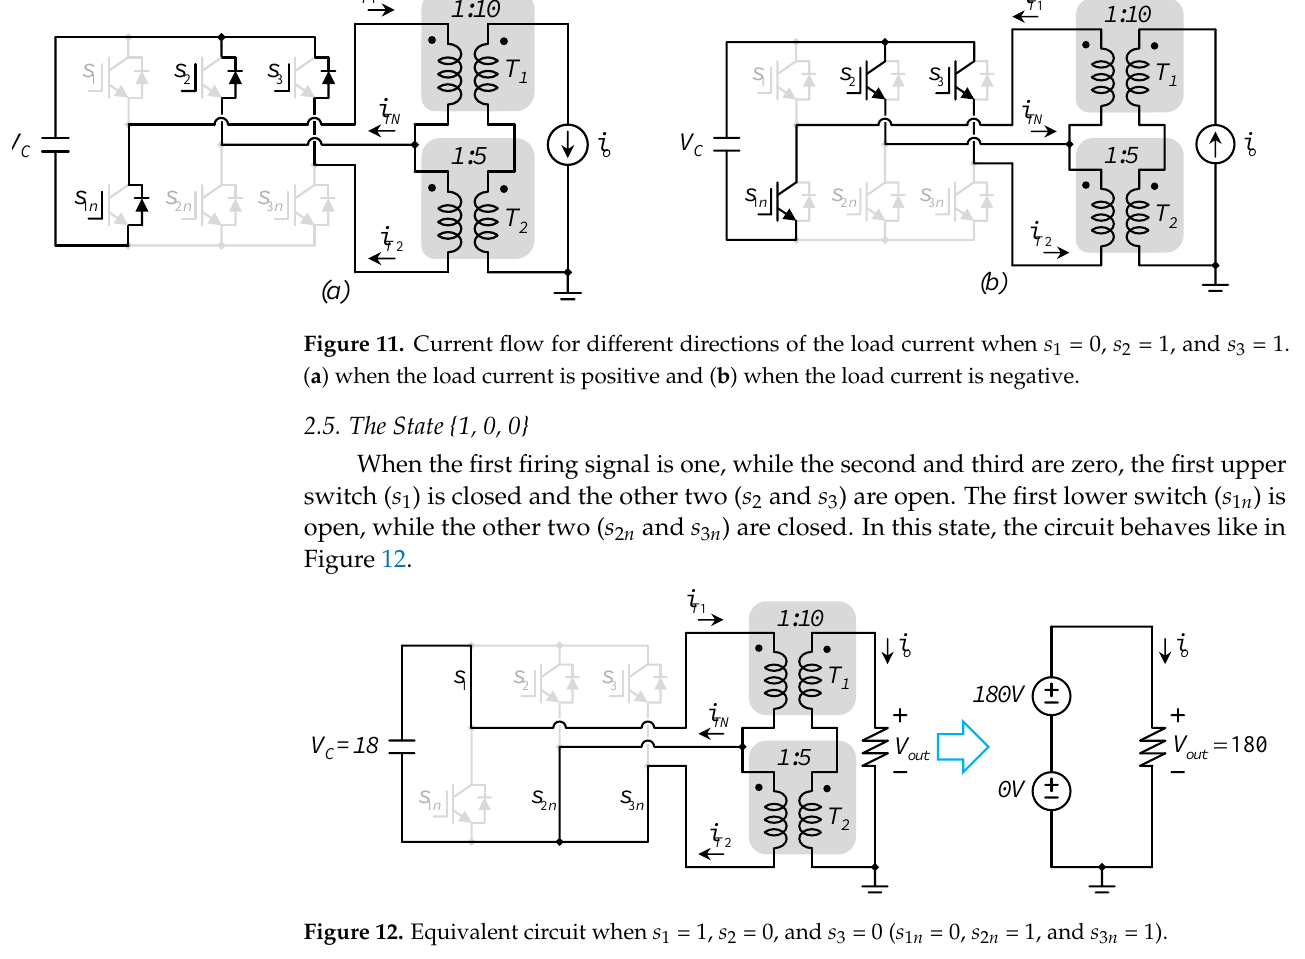
Figure 13. Current flow for different directions of the load current when s 1 = 1, s 2 = 0, and s 3 = 0. (a) when the load current is positive and (b) when the load current is negative. 2.6. The State {1, 0, 1} When the first and the third firing signals are one, while the second signal is zero, the first and the third upper switches ( s 1 and s 3 ) are closed while the second upper switch ( s 2 ) is open. The first and the third lower switches ( s 1 n , and s 3 n ) are open, while the other switch ( s 2 n ) is closed. In this state, the circuit behaves like in Figure 14.